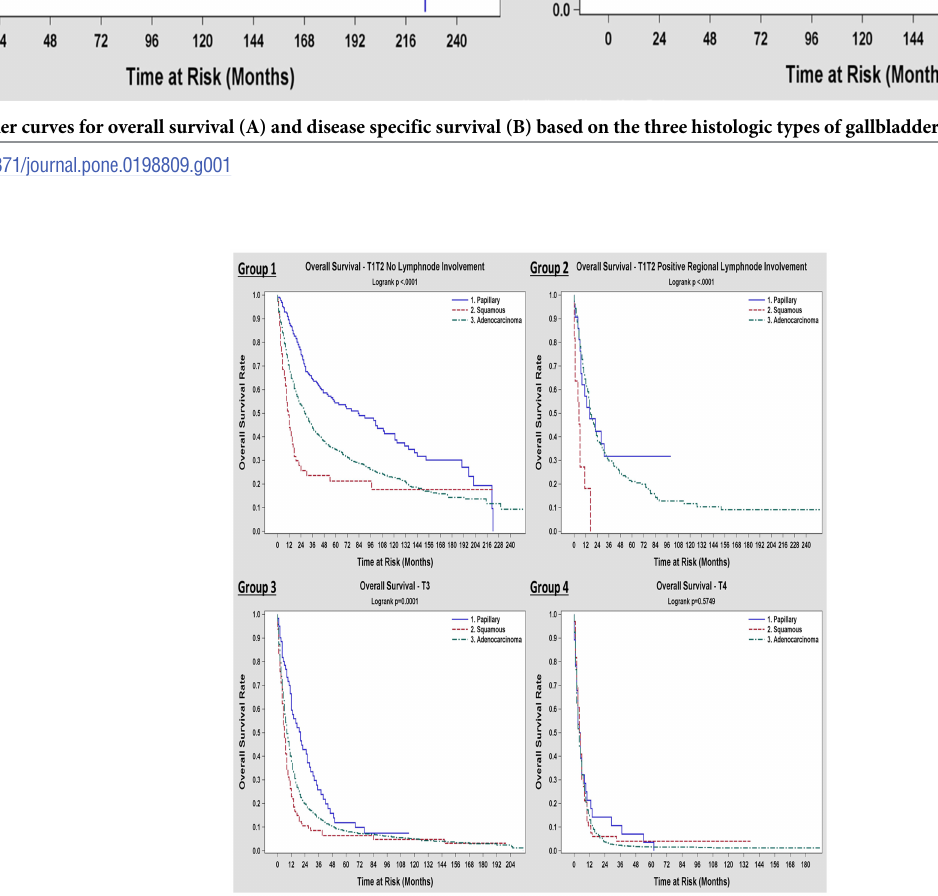
PLOS ONE | https://doi.org/10.1371/journal.pone.0198809 June 11,